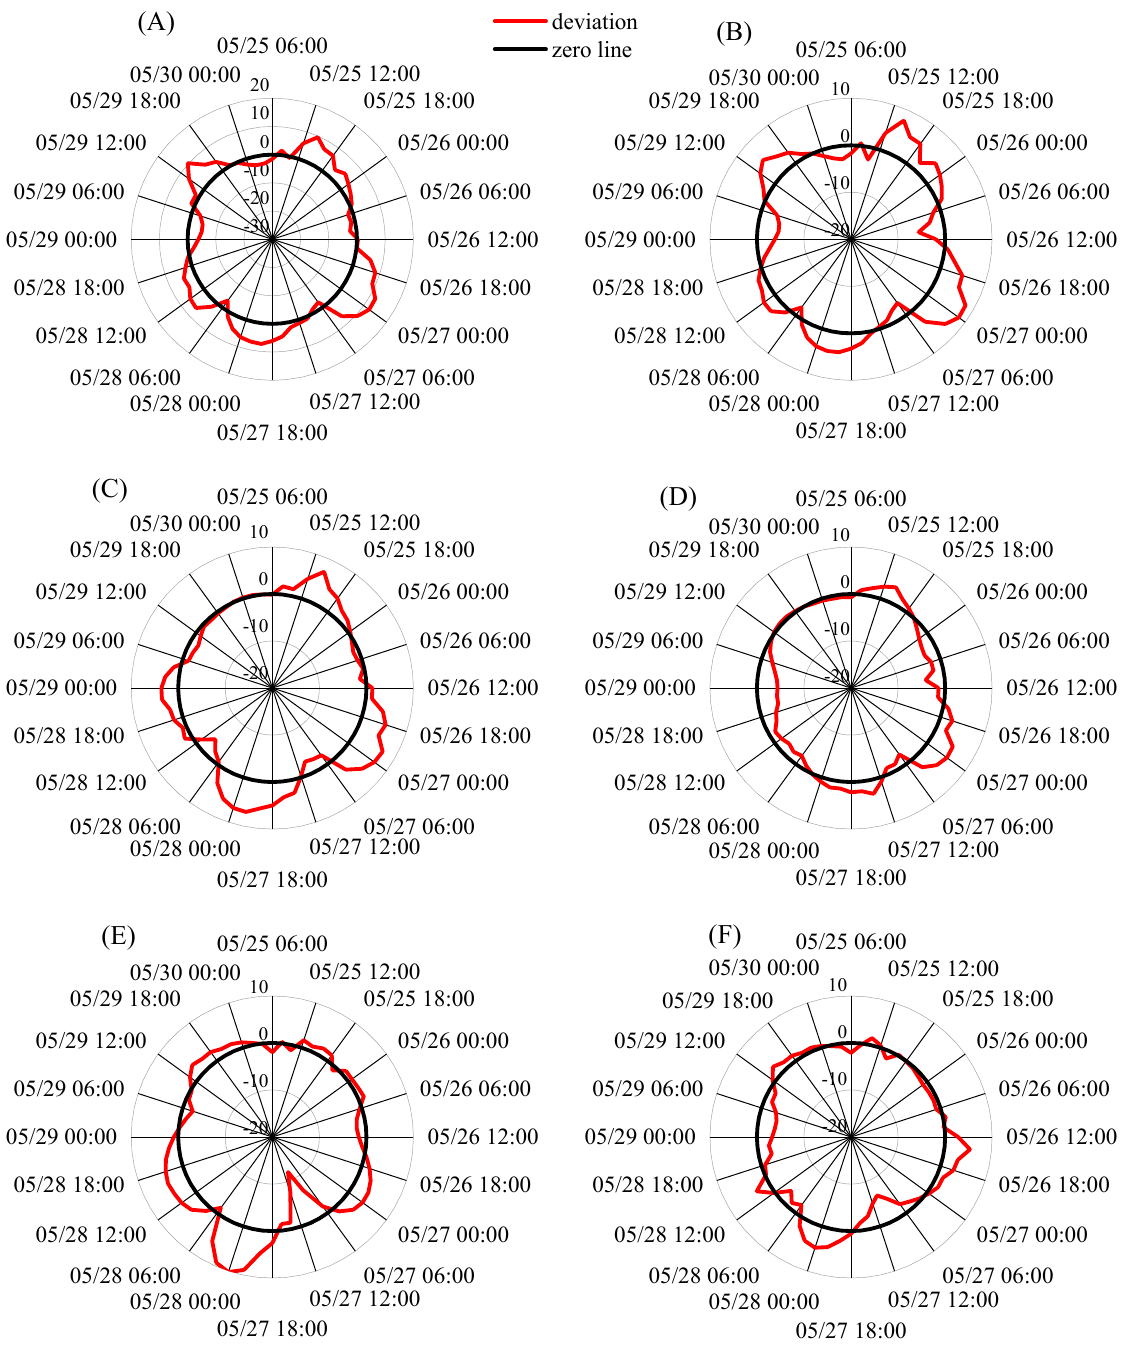
Figure 12. Deviation of the latent heat flux ( λ E) with vs. without inclusion of C sm in the SMAS model for the six treatments: ( A ) T1; ( B ) T2; ( C ) B1; ( D ) B2; ( E ) G1; ( F ) G2.